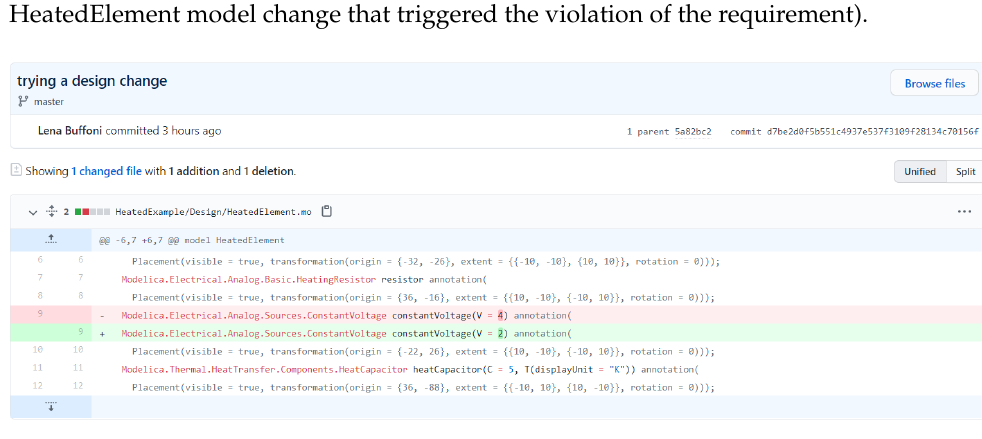
Figure 16. Different versions of a design